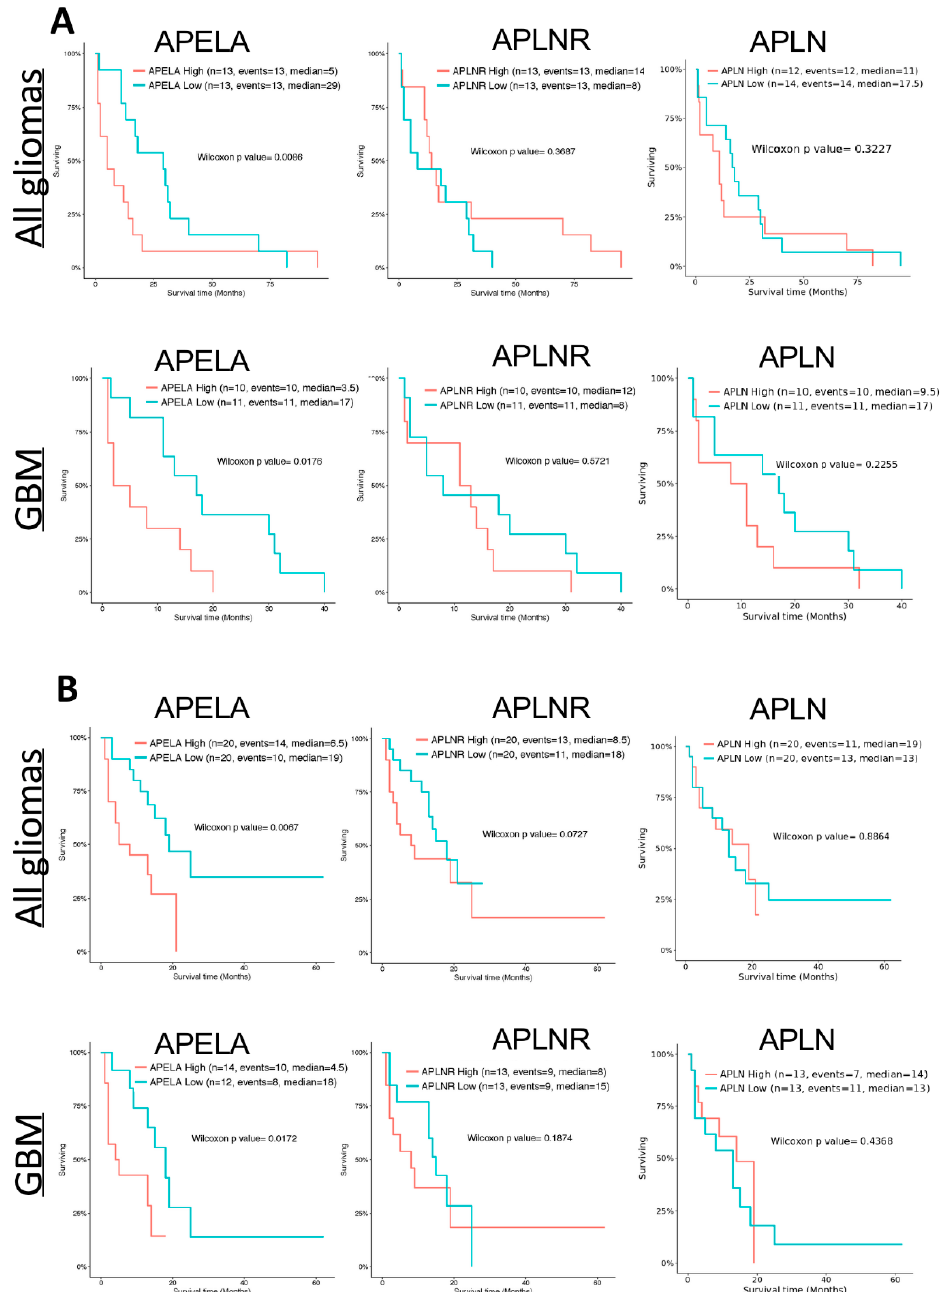
Figure 5. APELA expression is directly associated with glioma and GBM patient survival. ( A , B ) Kaplan–Meier curves of the association of APELA, APLNR and APLN expression with patient survival in the ( A ) Donson (GSE33331) [19] and ( B ) Vital (GSE43289) [20] microarray dataset analyzed using the GlioVis data portal [18].